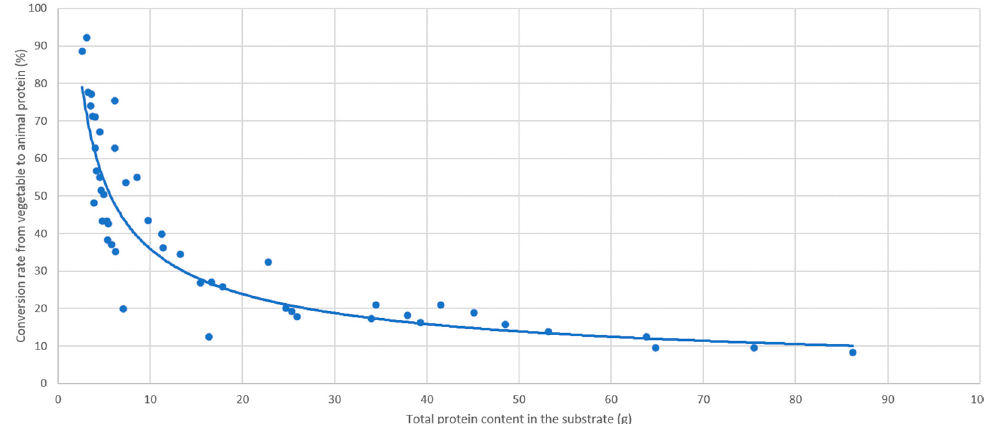
Figure 3. Conversion rate (%) of vegetable protein present in the substrate into BSF protein (absolute amounts, starting from 300 BSF larvae).